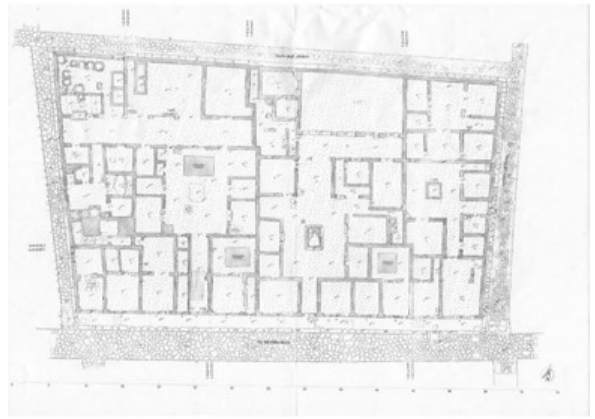
Figure 1. Map of Regio VII, Insula 14.